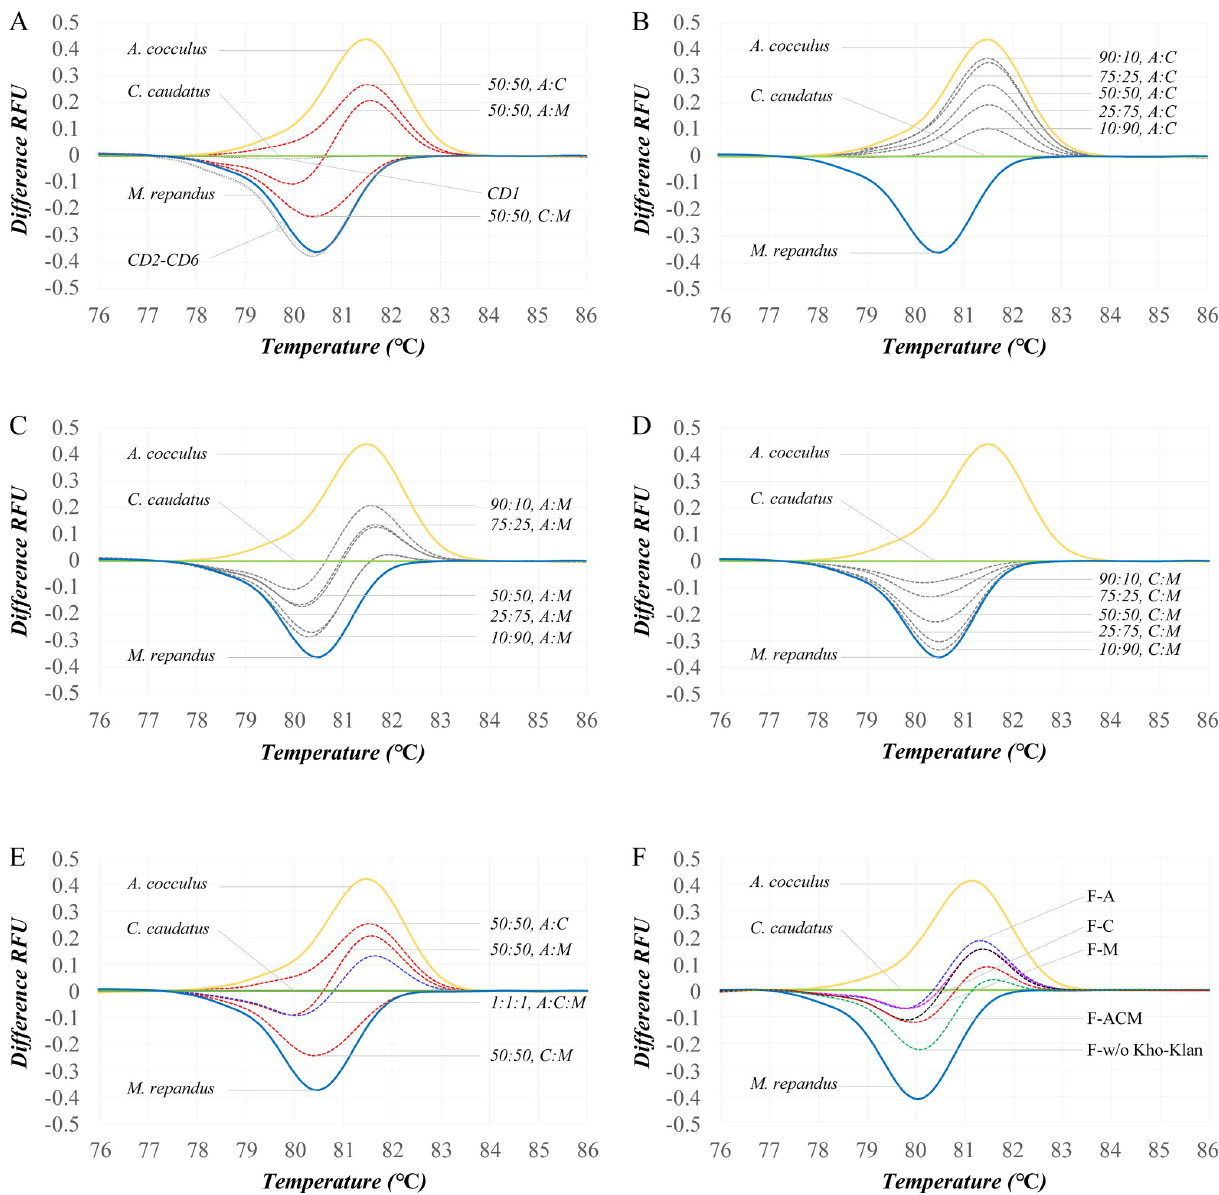
Fig 6. Difference plots of samples obtained by Bar-HRM. (A) Purchased Kho-Khlan crude drugs, (B) A . cocculus and C . caudatus mixture, (C) A . cocculus and M . repandus mixture, (D) C . caudatus and M . repandus mixture, (E) mixture of two and three species at equal amounts, and (F) laboratory- made YPSKK formulae. Mixture ratios are indicated. Authentic A . cocculus , C . caudatus and M . repandus are